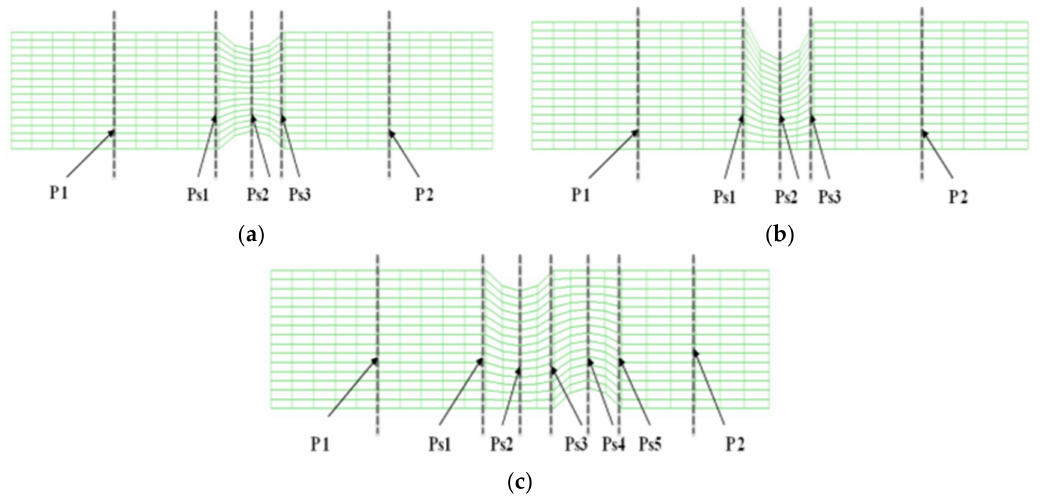
Figure 10. Grid mesh used in the fluid and solid models. ( a ) Model 1, ( b ) model 2, and ( c ) model